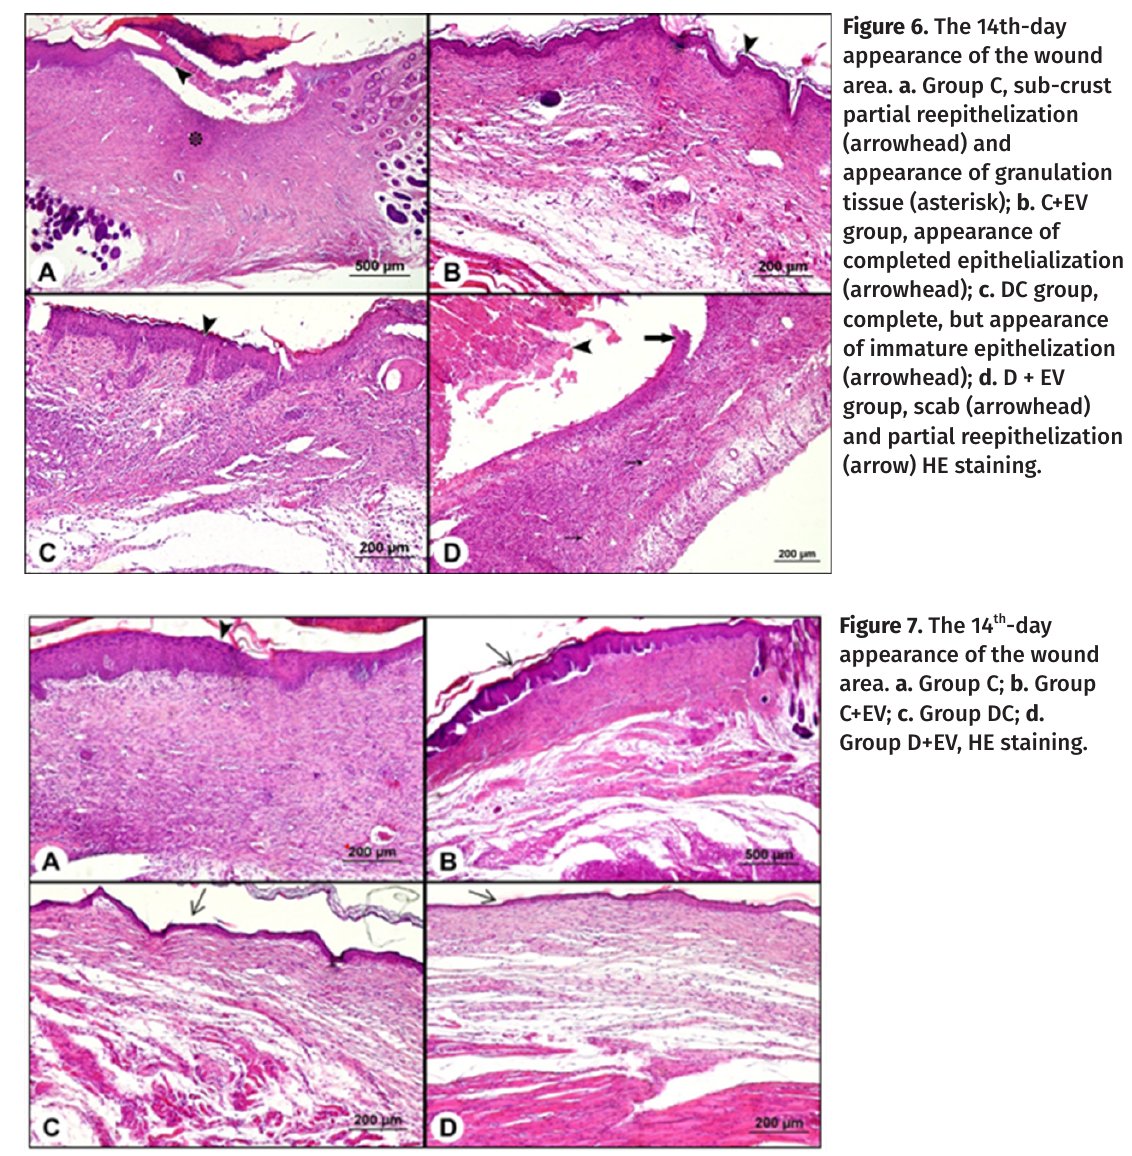
Figure 6. The 14th-day appearance of the wound area. a. Group C, sub-crust partial reepithelization (arrowhead) and appearance of granulation tissue (asterisk); b. C+EV group, appearance of completed epithelialization (arrowhead); c. DC group, complete, but appearance of immature epithelization (arrowhead); d. D + EV group, scab (arrowhead) and partial reepithelization (arrow) HE staining.